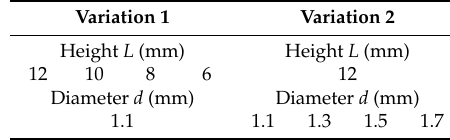
Figure 3. Overview of all manufactured parts as well as heat treatment conditions and orientation.